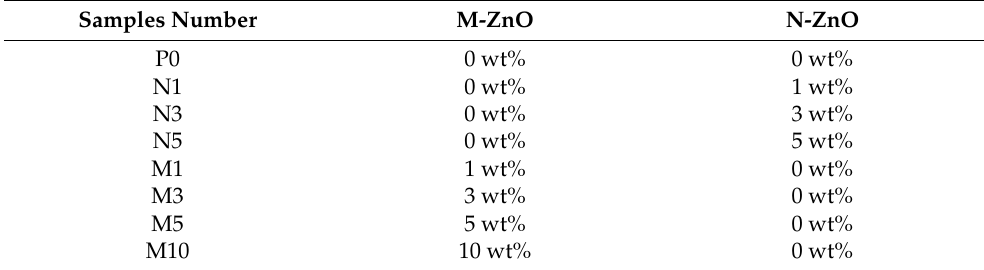
Table 2. Number and material composition of different samples.